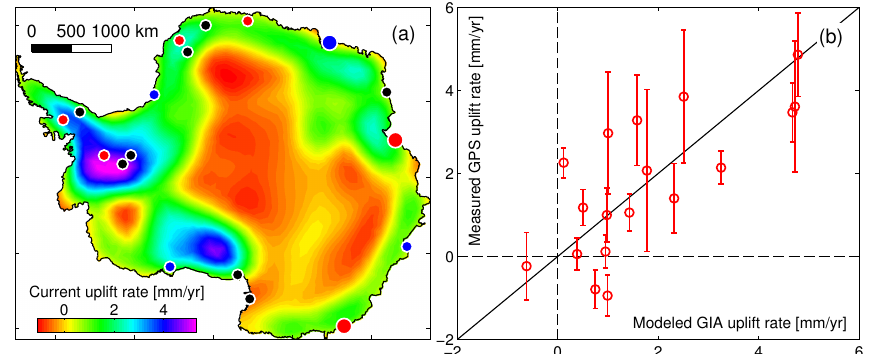
Figure 2. Model tuning and predictions of current uplift rate. (a) Modeled GIA uplift rate at the present day. Calculations are made by forcing the ISSM/GIA model by ice loading history over the past 21kyr (Supplement Fig. S2) (Ivins et al., 2013). Black circles locate the position where model results are within the 1- σ uncertainty range of GPS measurements (Fig. 2b). Red circles represent cases where the model overestimates the measurements, whereas blue circles indicate locations where the model underperforms. Big circles are to denote the absolute misfits that are > 0 . 75mmyr − 1 . (b) Validation of the model against 18 high-precision GPS uplift data (Thomas et al., 2011). Error bars depict 1- σ uncertainties associated with the GPS